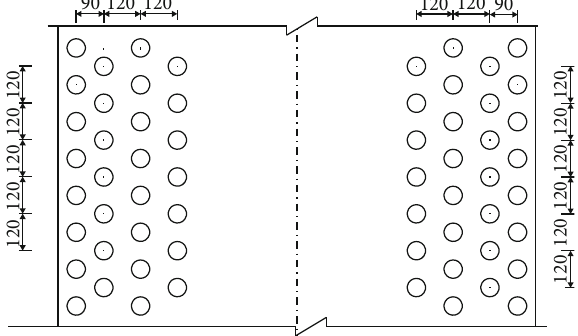
Figure 8: Schematic diagram of basement grouting layout (units: